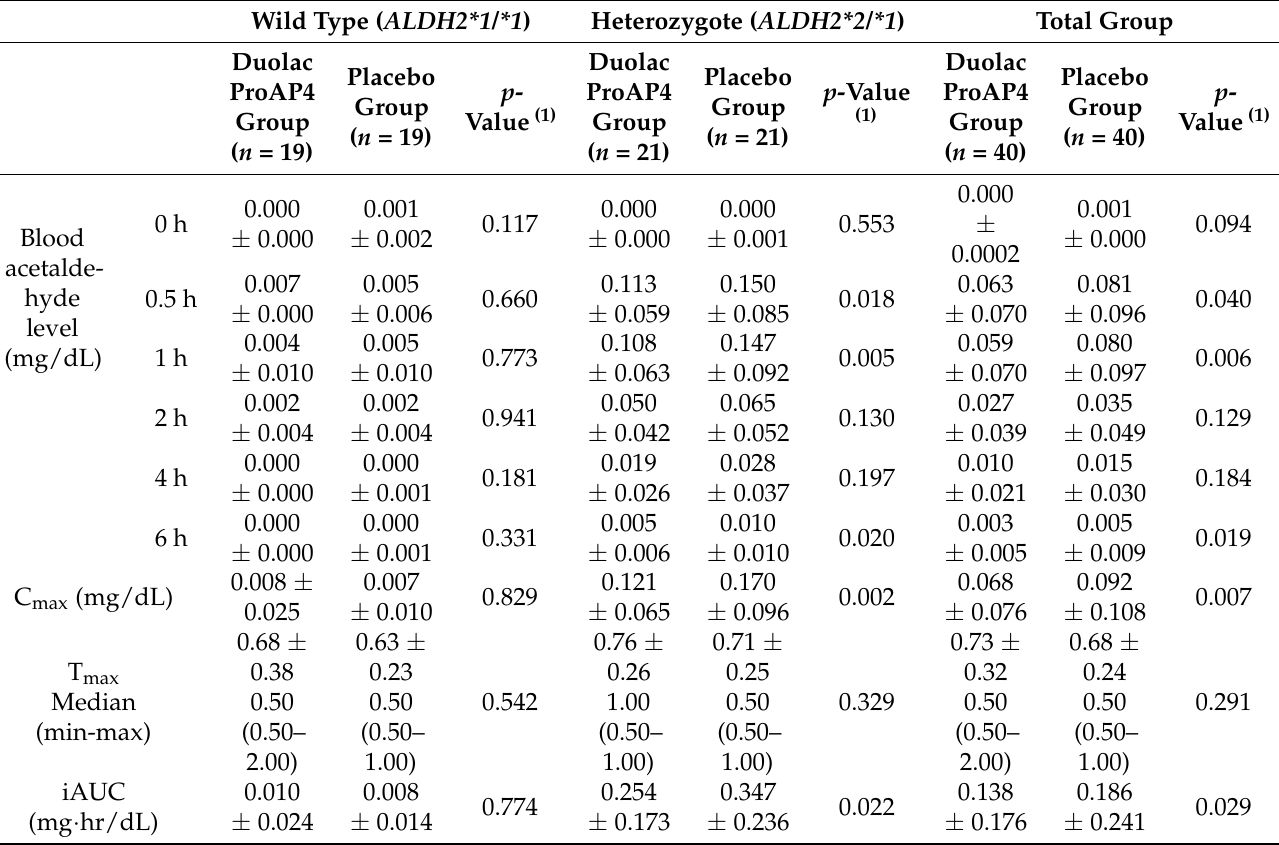
Table 2. Variation in blood acetaldehyde concentration flowing alcohol challenge test after 15 days of